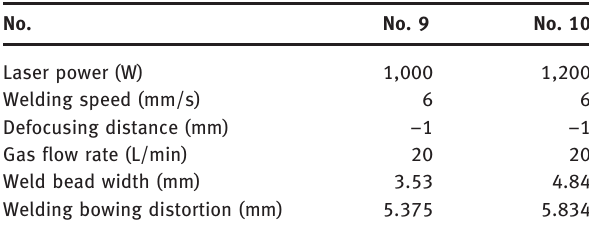
Table 9: Welding parameters and bead width corresponding to Figure 11.